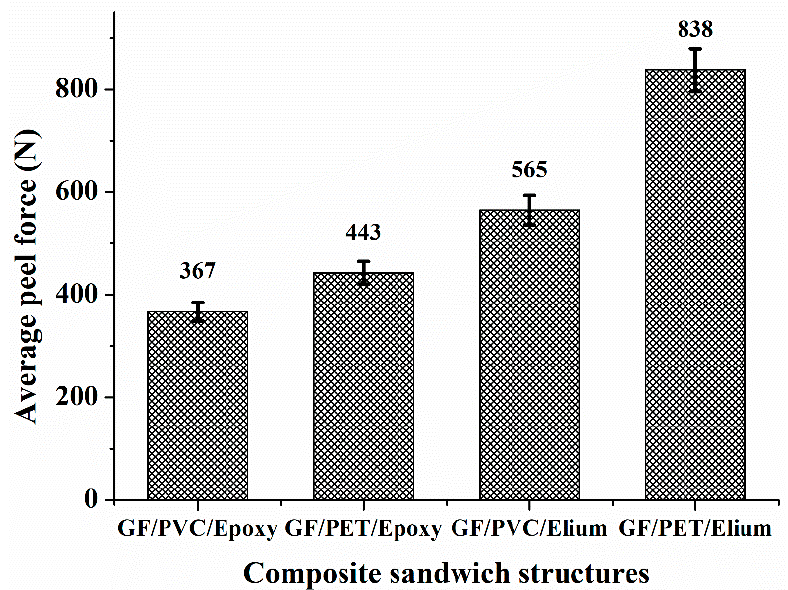
Figure 9. Peel strength of GFRP sandwich composite structures.